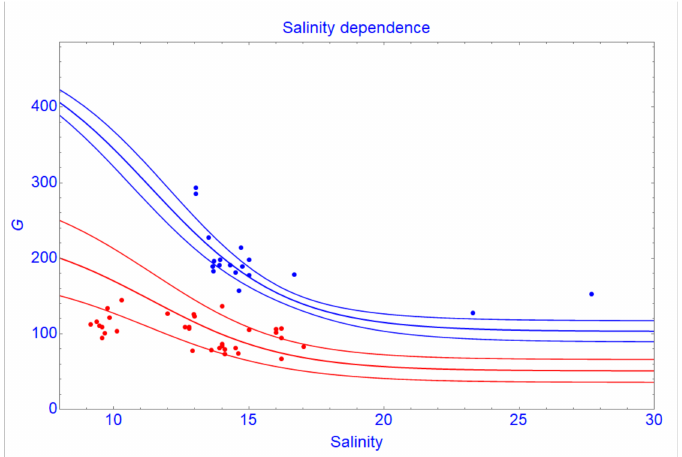
Figure 3. Growth rate of the trees in the plots which are located on large salinity gradients and have the same range of tree density. The red points and curves are the data plots and the section and 95% confidence bands constructed at a density of 80 trees per plot, respectively. The blue points and curves are the data plots and the section and 95% confidence bands constructed at a density of 15 trees per plot, respectively.